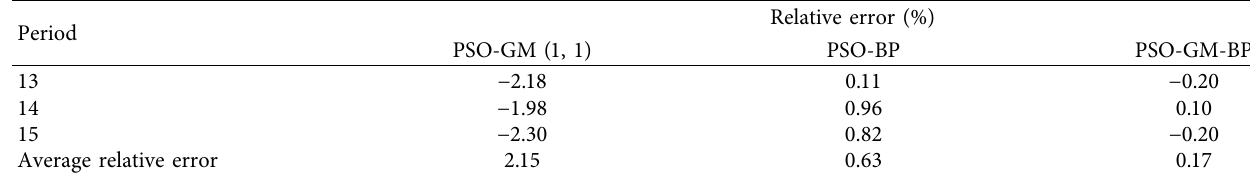
Table 15: Comparison of relative error of three